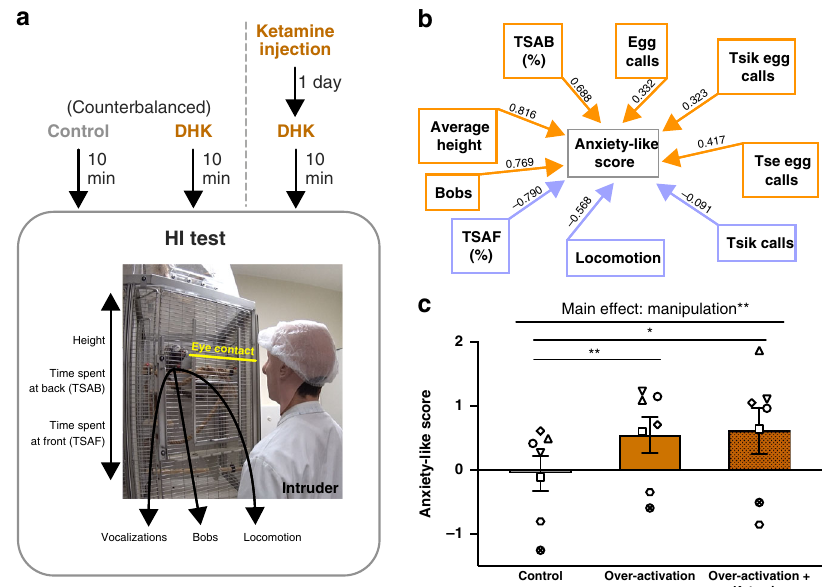
Fig. 6 Ketamine does not reverse heightened anxiety-like behavior induced by sgACC/25 over-activation on the Human Intruder (HI) test. Gray = control, orange = over-activation. Error bars represent SEM. n = 7. a All seven animals had three HI testing sessions. The fi rst two sessions were counterbalanced, consisting of a control (saline) infusion or over-activation using DHK. The fi nal session consisted of over-activation 24 h following ketamine administration. In the test, marmosets are divided into a quadrant of their cage and are confronted with a novel intruder who maintains eye contact for 2 min. Marmosets display a range of behaviors including vocalizations (tsik, tsik egg, tse egg, and egg calls), bobbing (rapid side-to-side movements of head and body), and locomotion. b These behaviors — together with average height, the time spent at the back of the cage (TSAB), and the time spent at the front of the cage (TSAF) — are loaded onto a single EFA-extracted factor representing anxiety-like behavior, with weightings shown above the arrows. c Replicating a previous fi nding from our group, sgACC/25 over-activation alone resulted in a signi fi cant increase in anxiety-like factor scores (one-way repeated measures ANOVA, effect of manipulation, F 1.6,9.7 = 13.3, p = 0.002, η 2 = 0.138; control vs . over-activation, p = 0.003, d = 2.23). This effect was not reversed by ketamine (Sidak ’ s test, over-activation vs. over-activation + ketamine, p = 0.973): compared to control conditions, sgACC/25 over-activation following ketamine administration still resulted in elevated factor scores (Sidak ’ s test, control vs. over-activation + ketamine, p = 0.020, d = 1.54). Source data are provided as a Source Data fi